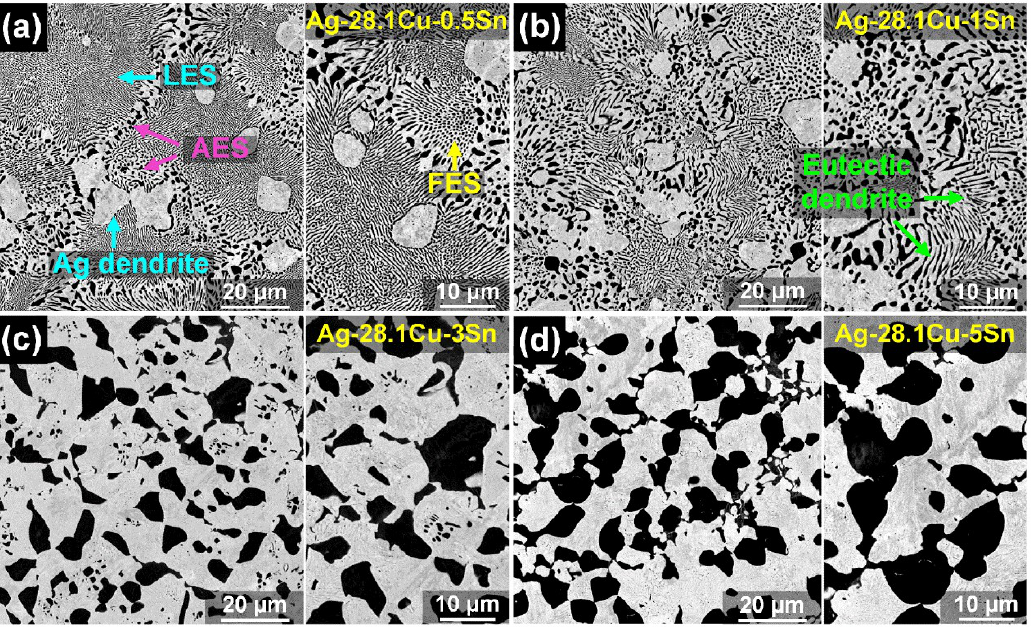
Figure 4. Eutectic morphologies in the Ag-Cu eutectic alloys solidified at 10 K/s with different Sn additions: ( a ) Ag-28.1Cu-0.5Sn, ( b ) Ag-28.1Cu-1Sn, ( c ) Ag-28.1Cu-3Sn and ( d ) Ag-28.1Cu-5Sn.